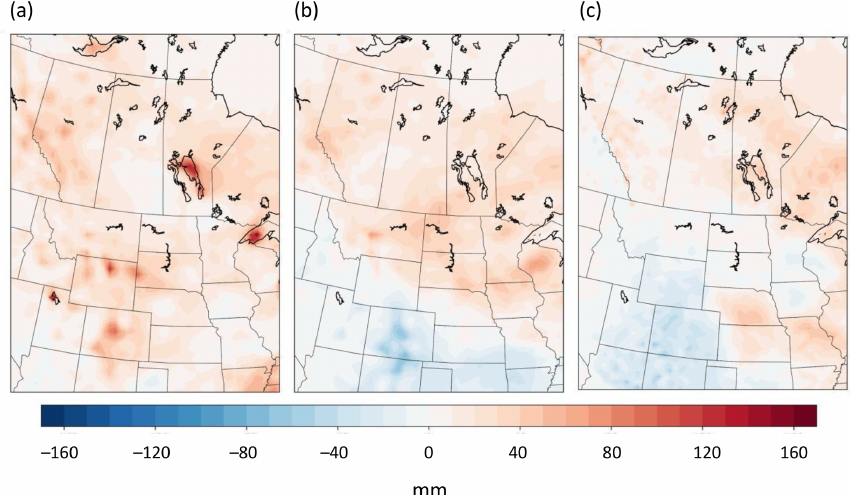
Figure 11. Changes in future warm season (JJA) convective precipitation (mm) for three NARCCAP model pairs of (a) MM5-HadCM3, (b) MM5-CCSM, and (c) HRM3-HadCM3. Positive values imply greater future precipitation (i.e., 2041–2070 minus